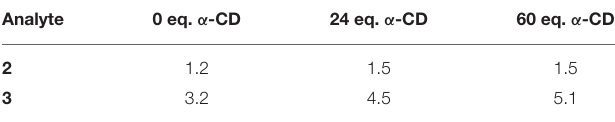
TABLE 2 | Ratio of oxidation to chlorination products formed by treating aromatic analytes 2 and 3 with chlorine dioxide with varying cyclodextrin equivalents a .